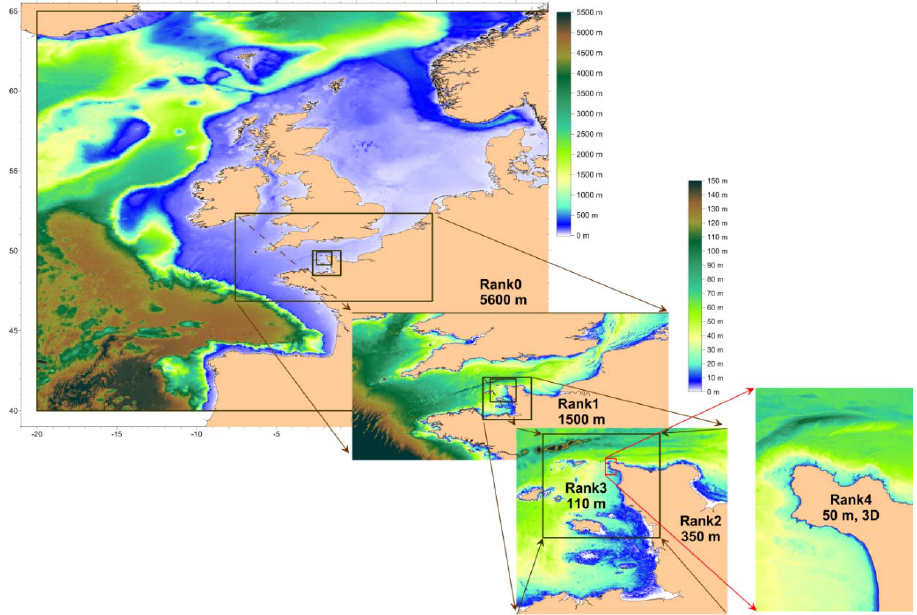
Figure 4. Example of model nesting for the La Hague Cape area, Ranks 0–2 are two ‐ dimensional (2D), Rank3 is 2D or three ‐ dimensional (3D), Rank4 is 3D, adapted from [26].